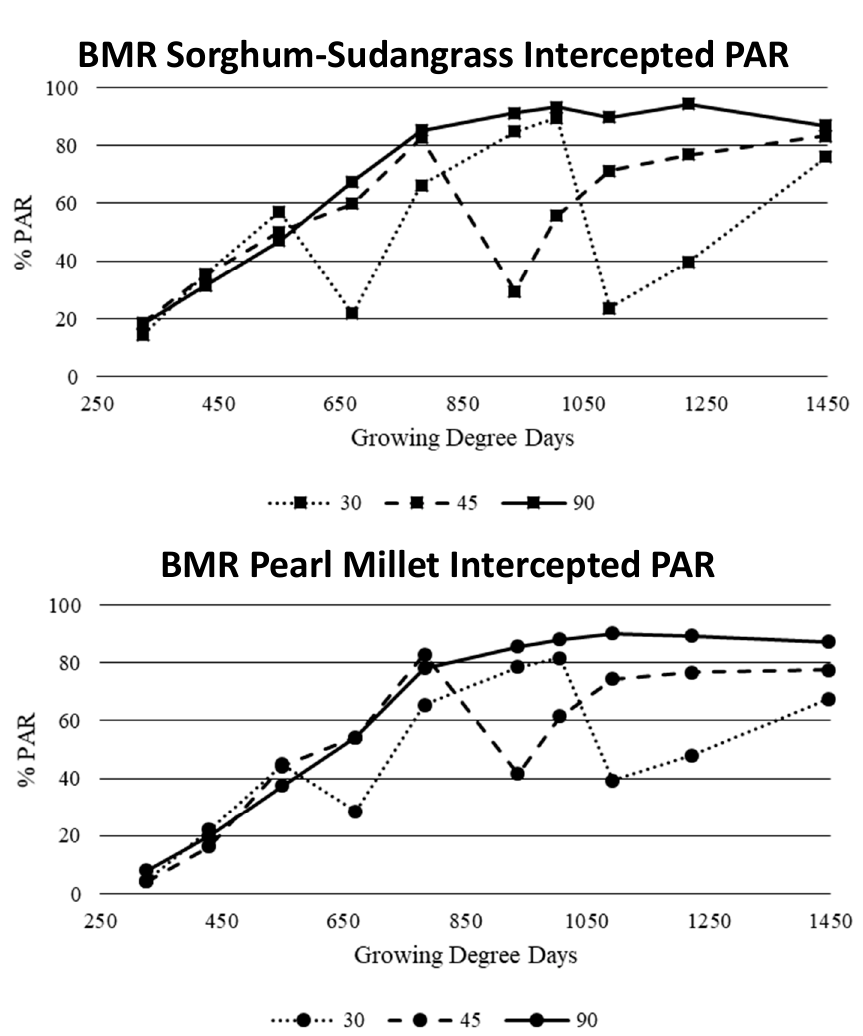
Figure 4. Brown midrib (BMR) sorghum-sudangrass and BMR pearl millet intercepted photosynthetically active radiation (PAR) for three different harvest intervals (three 30-d, two 45-d, and one 90-d) in 2016 at Canyon, TX, USA.